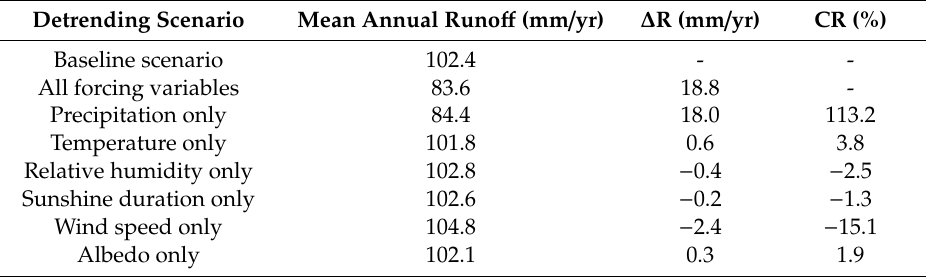
Table 2. The basin-average ∆ R and CR under di ff erent detrending scenarios. ∆ R denotes the di ff erence in mean annual runo ff simulations obtained from the baseline scenario and the detrending scenario for a single forcing variable (or all forcing variables) during the period 1981–2014. CR denotes the contribution rate of a single forcing variable to runo ff change during the period